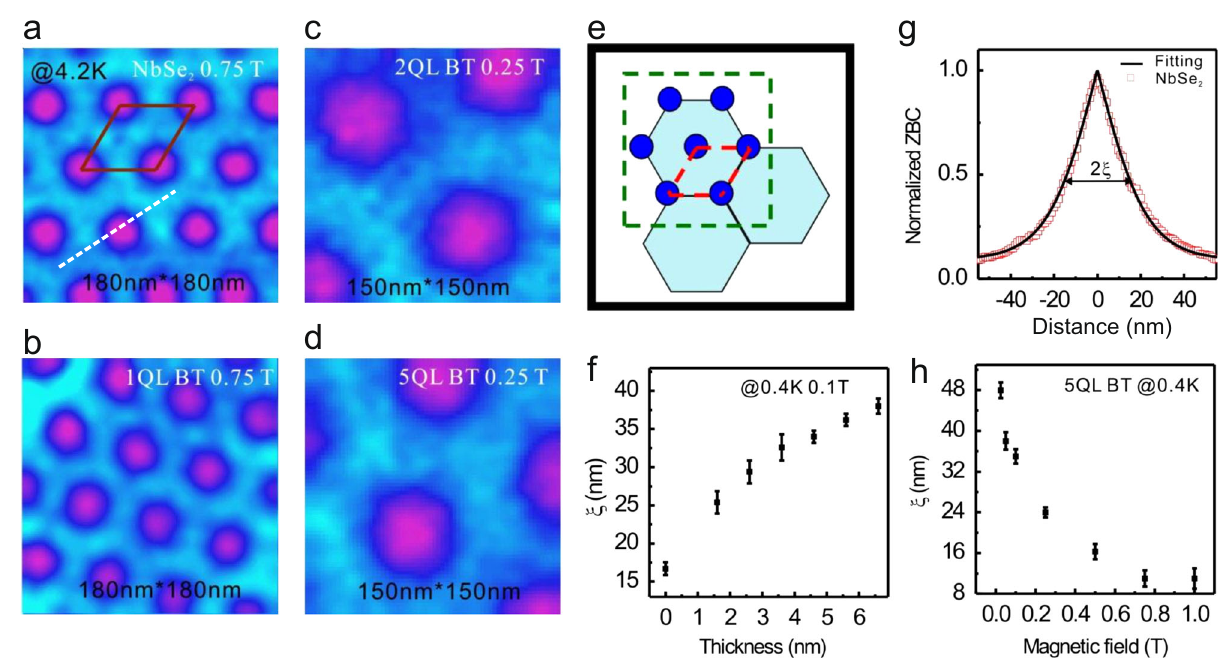
Fig. 3 Abrikosov vortices on Bi 2 Te 3 /NbSe 2 heterostructure at different magnetic fi eld. a , b 0.75 T for NbSe 2 and 1 QL Bi 2 Te 3 . c , d 0.25 T for 2 QL and 5 QL Bi 2 Te 3 . e The calculated magnetic fl ux of a vortex. f Thickness dependence of the coherence length. g Normalized ZBC pro fi les crossing through the centers of vortices at 0.4 K and 0.1 T on NbSe 2 . The superimposed lines are fi tted results using Ginzburg – Landau theory. h The coherence length as a function of the magnetic fi eld measured on 5 QL Bi 2 Te 3 /NbSe 2 . f and h reprinted with permission from ref. 15, copyright 2014 by the American Physical Society